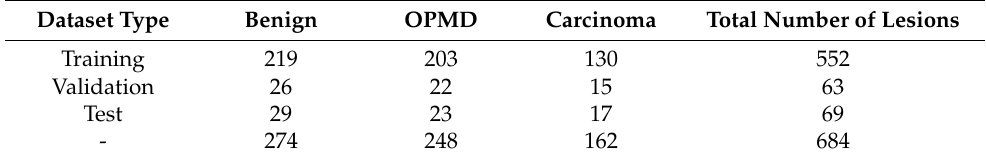
Table 2. Number of images for classification experiments according to lesion class and dataset